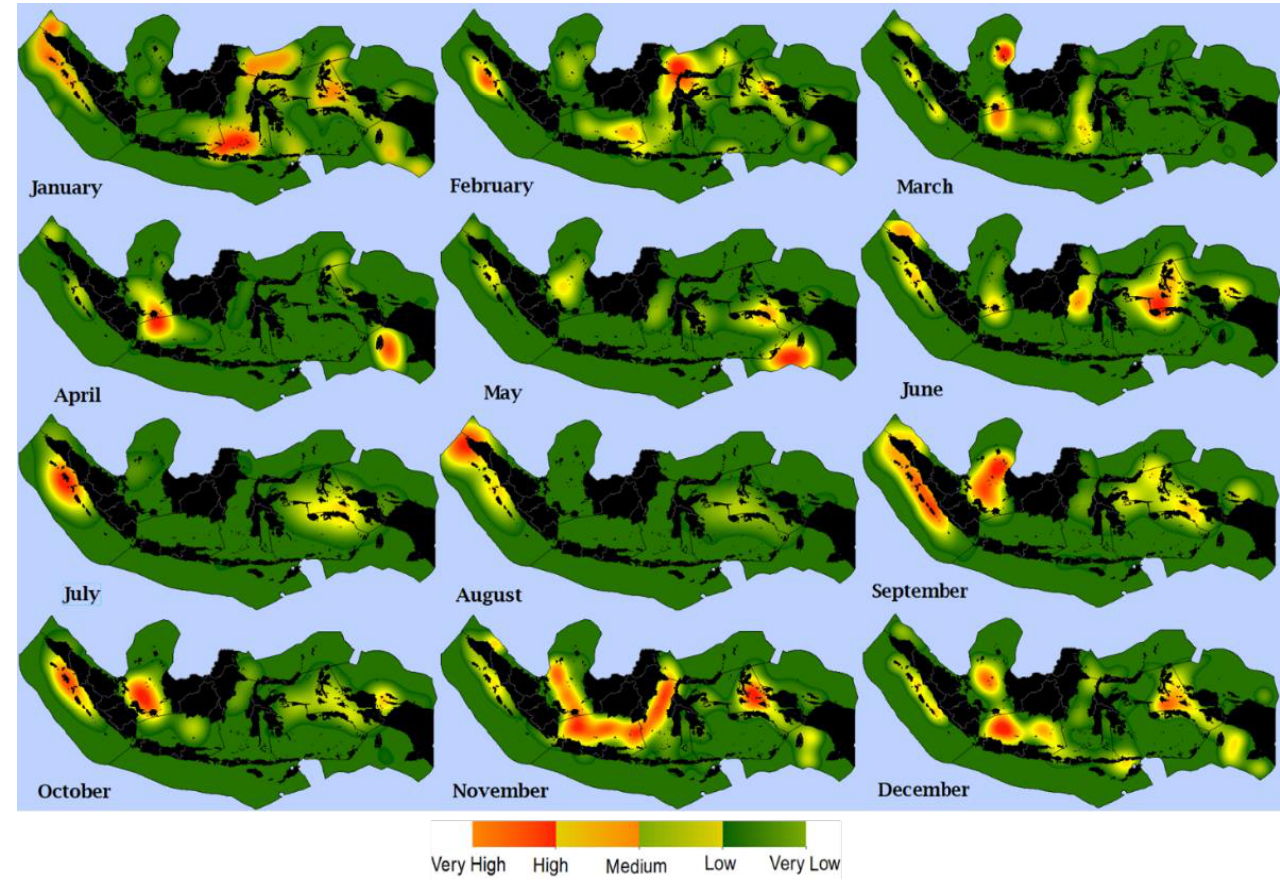
Figure 5. Monthly potential fishing zones in 2018.